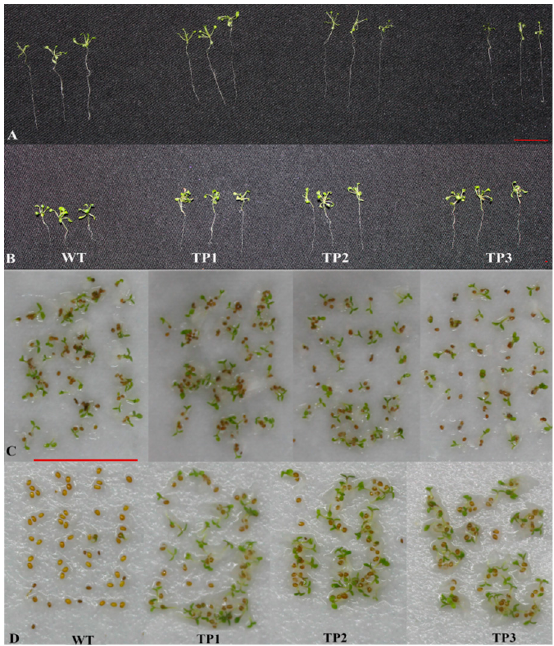
Figure 3. Germination rates and primary root lengths of WT and TPs under normal and salt stress conditions. ( A ) Primary root lengths in 2-week-old transgenic plants and wild-type plants under non-stress treatment conditions. ( B ) Primary root lengths in 2-week-old transgenic plants and wild-type plants under 150 mM NaCl treatment. The transgenic lines grow faster than the wild-type plants. ( C ) Germination rates of 5-d-old transgenic seeds and wild-type seeds under non-stress treatment conditions. ( D ) The transgenic seeds germinated faster than the wild-type seeds under salt stress conditions. The scale bar represents 1 cm.